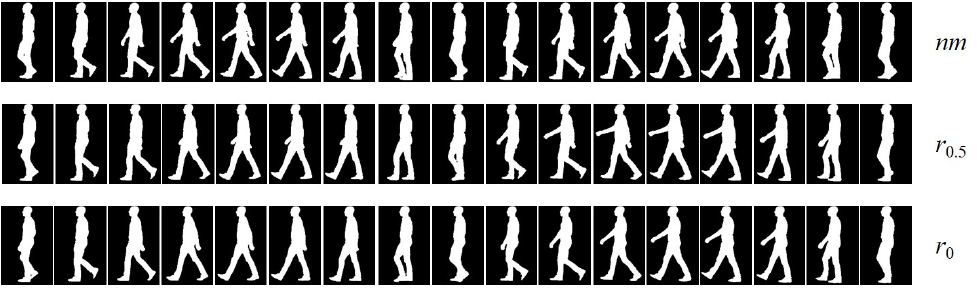
Figure 1. From top to bottom, key silhouettes from one-cycle gait sequences corresponding to the nm , r 0.5 , and r 0 styles, respectively. Their dynamics are observed from right to